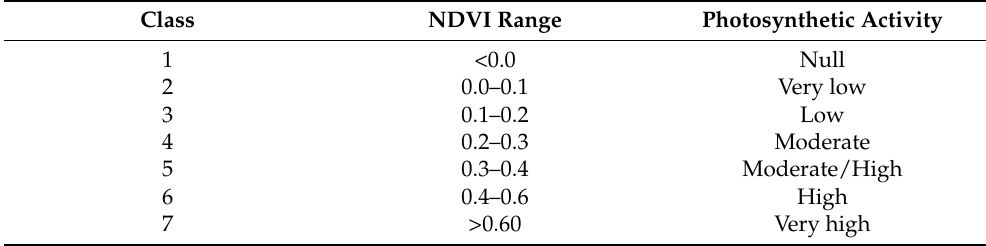
Table 3. NDVI classification. Source: adapted from [107].